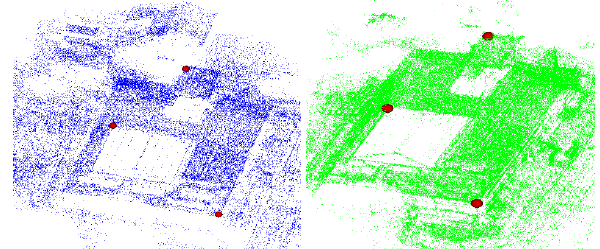
Figure 2. Two point clouds from fig. 1 with three homologous points. The markers were manually selected without identifying individual points of the